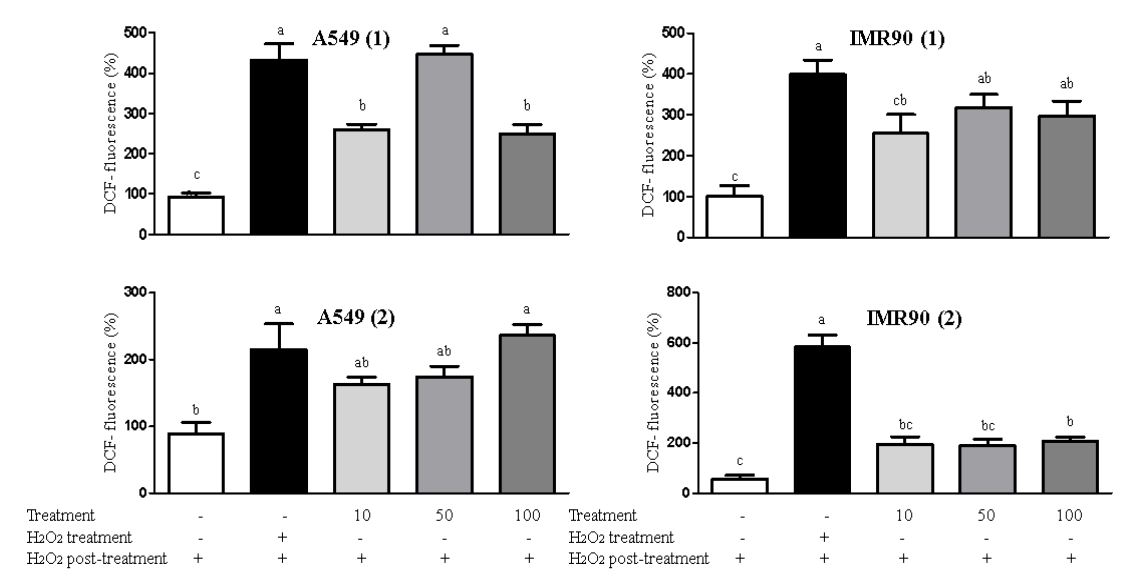
Figure 4. Results for intracellular ROS in A549 and IMR90 cells treated with 1 and 2 (10, 50 and 100 μM) as measured by spectrofluorometry. The data were analyzed by one-way ANOVA and quantitative data are expressed by mean ± standard deviation.* Different letters in the columns mean statistical difference.